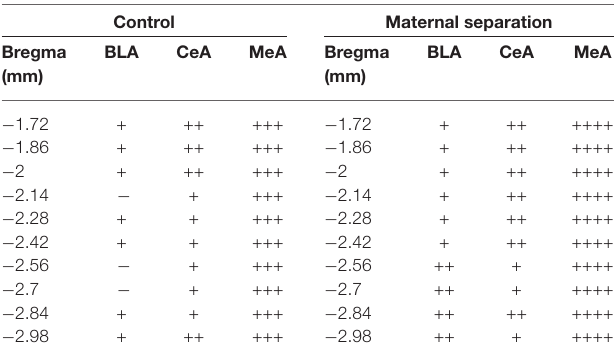
TABLE 2 | Vasopressin fiber density distribution in animal facility reared (AFR) and MS rats. Control Maternal separation